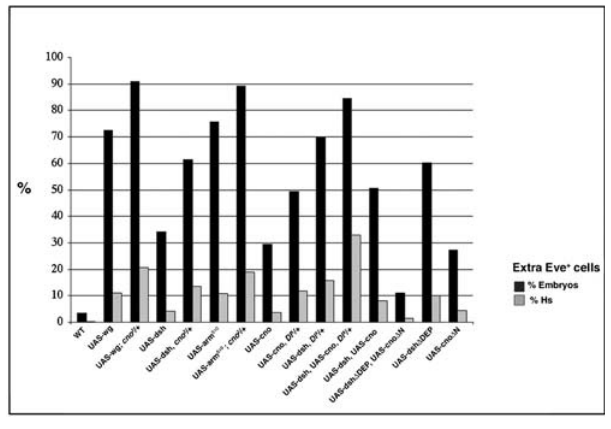
Figure 4. Cno inhibits Wg-Dsh pathway and links it with Dl-N pathway. Table shows % of embryos and hemisegments (Hs) for each indicated genotype that display extra Eve + cells. At least 70 embryos/770 hemisegments were counted in each case. P , 0.001 for all genotypes except for UAS-wg; cno 2 / + , ‘‘% Embryos bar’’ (P=0.0027); UAS-arm S10 , cno 2 / + , ‘‘% Embryos bar’’ (P=0.0337); UAS-cno, Dl x / + , ‘‘% Embryos bar’’ (P=0.0177); UAS-dsh, UAS-cno, Dl x / + , ‘‘% Embryos bar’’ (P=0.0472); UAS-dsh, UAS-cno, ‘‘% Embryos bar’’ (P = 0.0115), ‘‘% Hs bar’’ (P=0.0002).